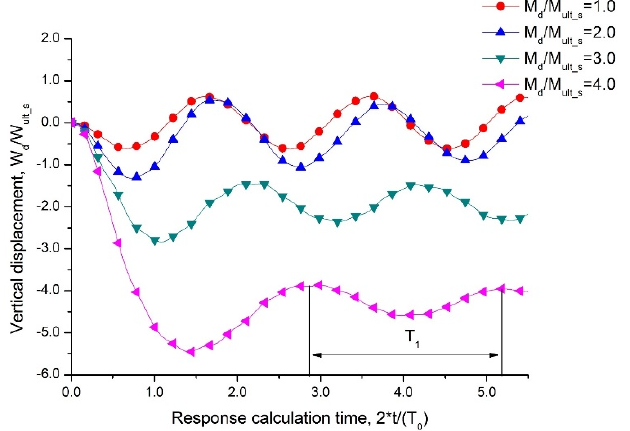
Figure 9. Vertical displacement response at mid-span as the response calculation time for box girder M2 with load duration time T d = 0.005 s.